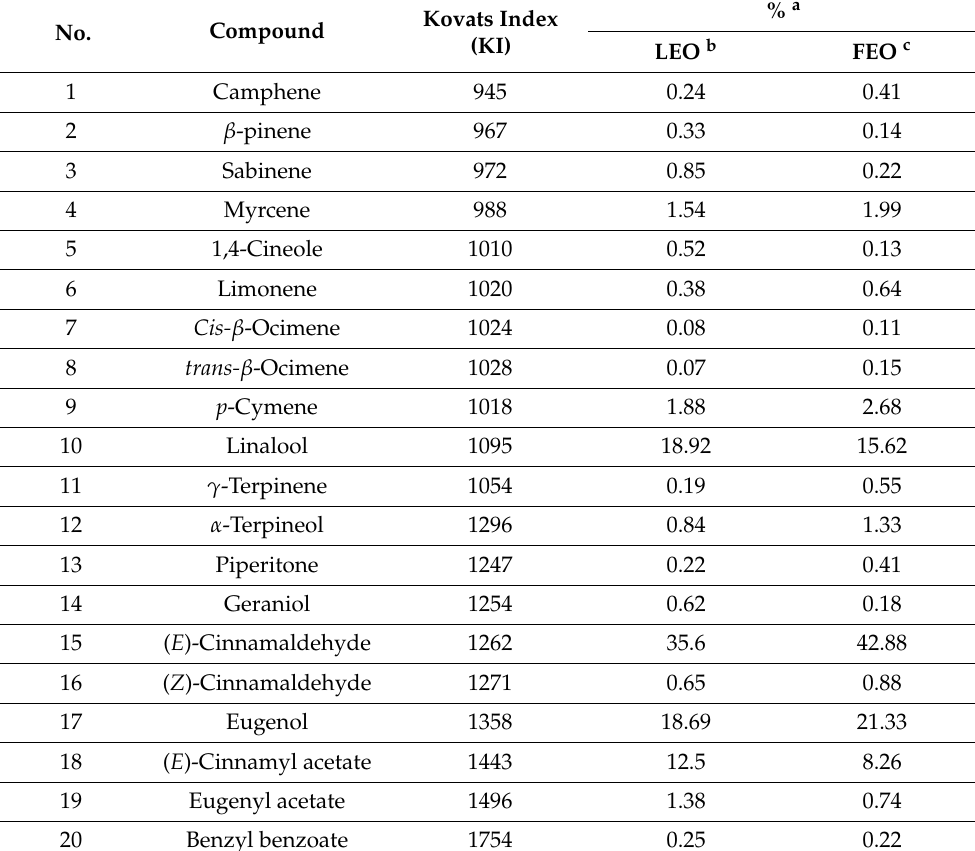
Table 1. GC-MS analysis of Cinnamomum verum LEO and FEO essential oils. No.